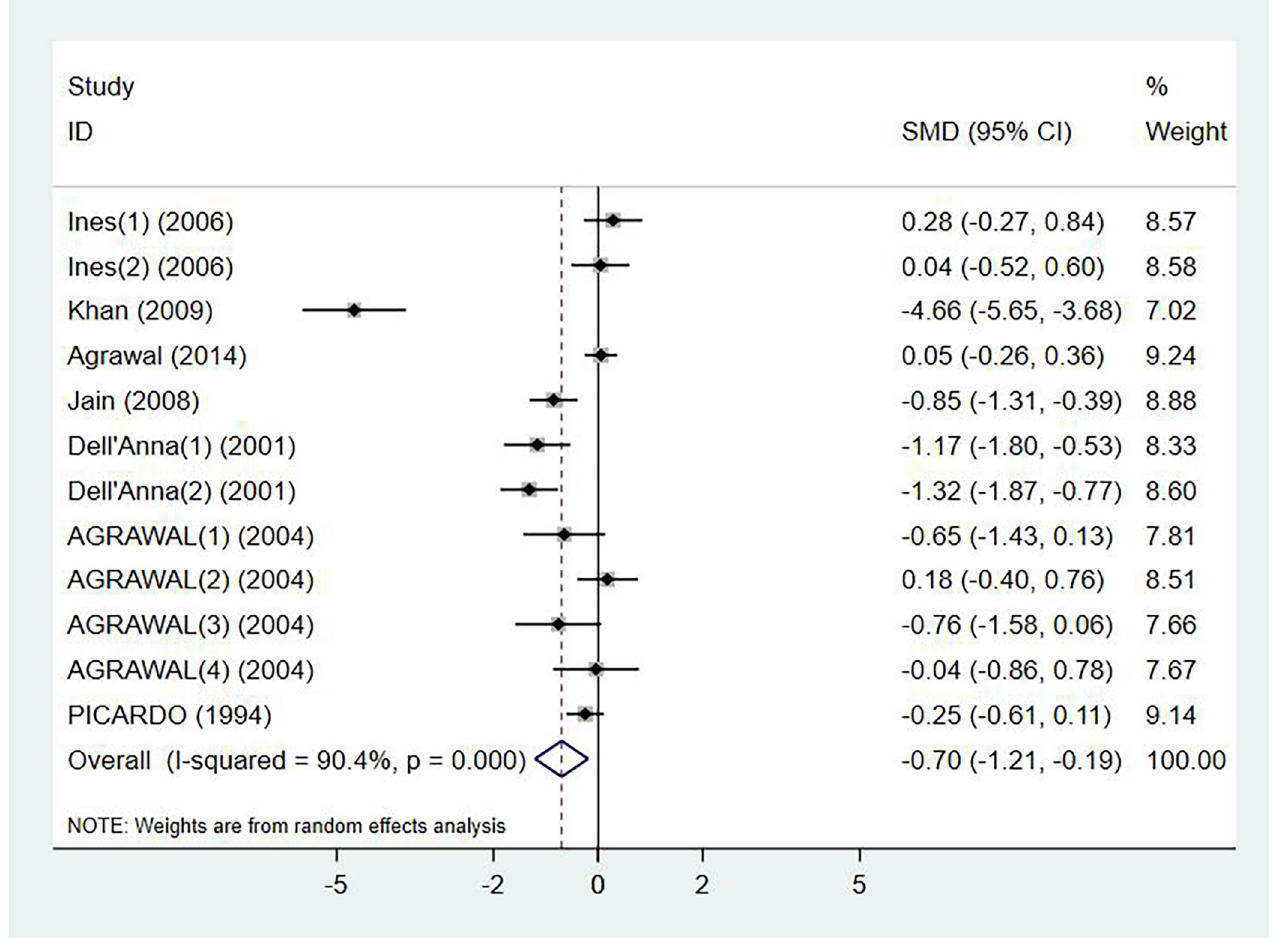
Fig 2. Forest plot in the meta-analysis of vitamin E levels and vitiligo.